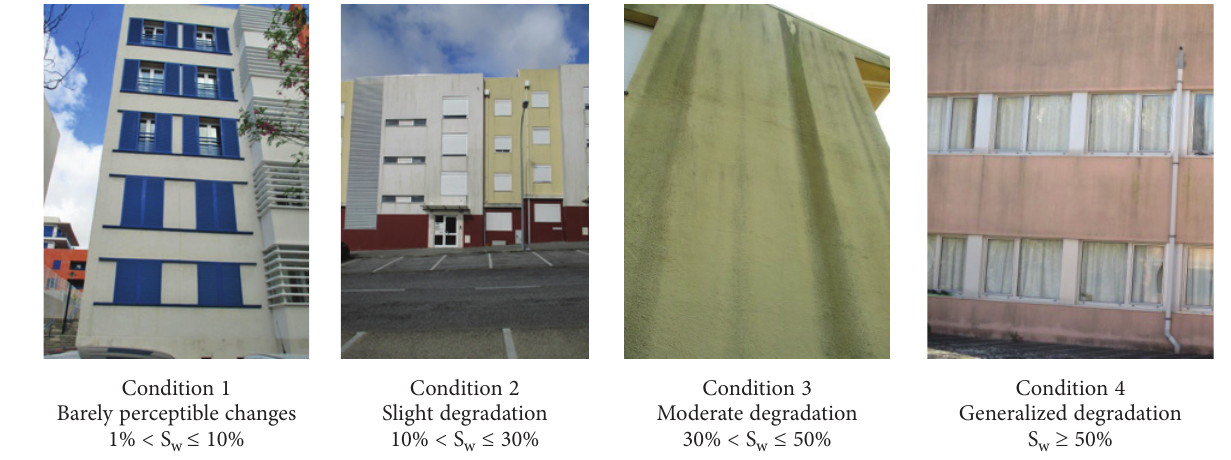
Figure 1. Illustrative example of the degradation conditions of ETICS